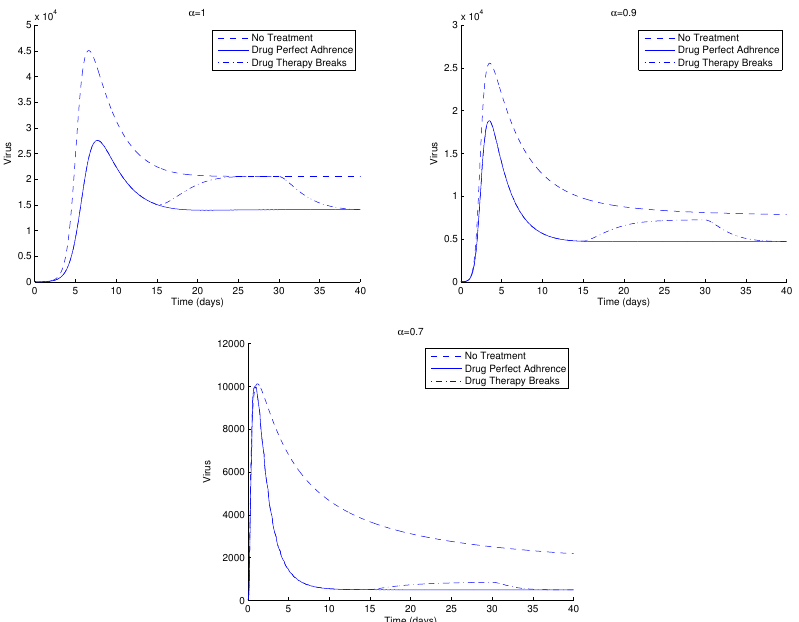
Figure 9. HIV, viral load, V , of system (1) for three different therapy strategies and for α = 1 ( top left ), α = 0.9 ( top right ) and α = 0.7 ( bottom ). Parameter values and initial conditions in the text, except R k = 1 and β 2 =